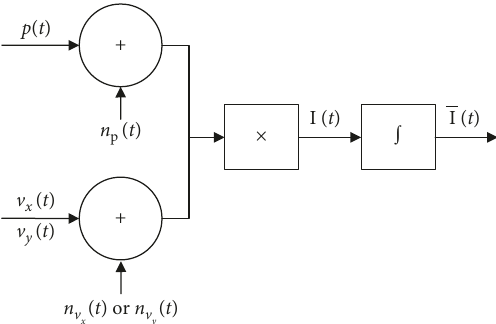
Figure 1: The directivity of the vector sensor when combining the pressure channel and velocity channels together: (a) p t p t v . The source bearing is 0. s ( ) ( ) +